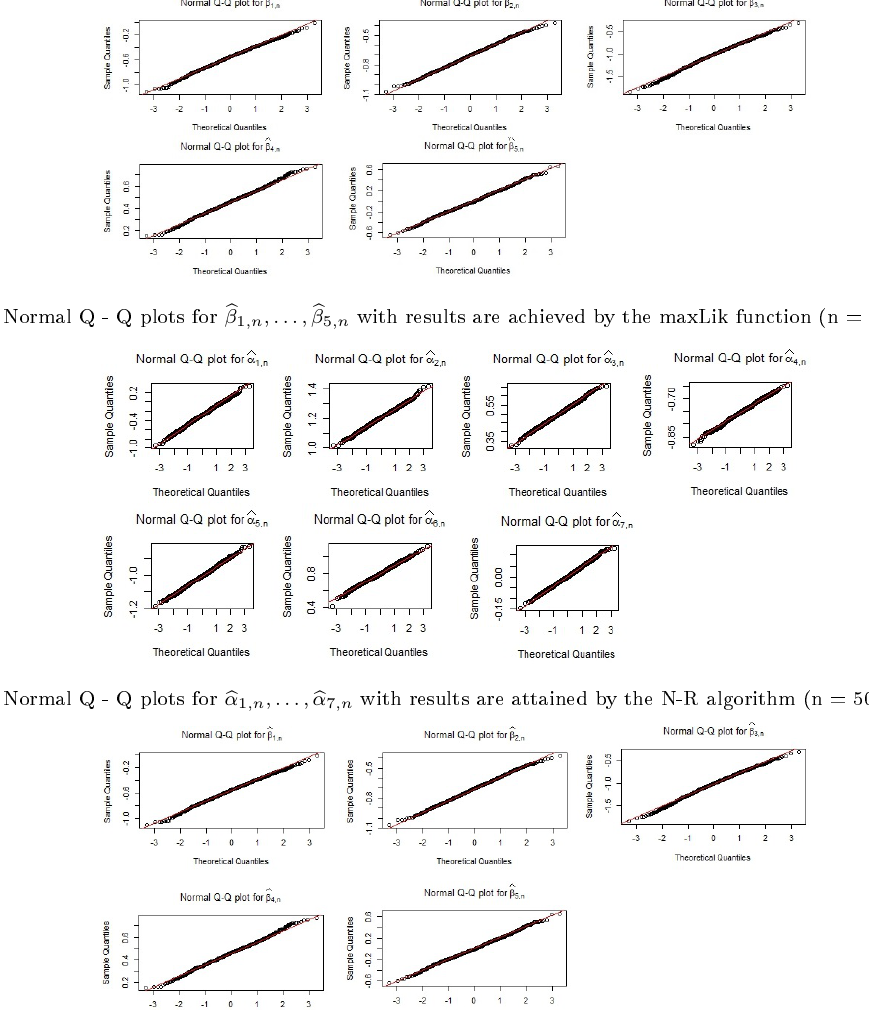
292 c (cid:13) 2018 Journal of Advanced Engineering and Computation